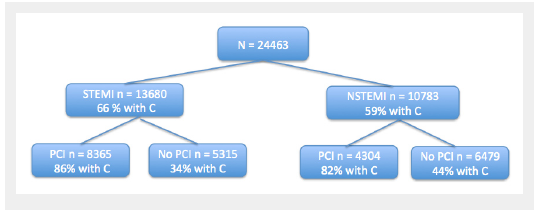
Flow chart of the patient regarding STEMI, NSTEMI and PCI or no PCI and percentage of patients treated with clopidogrel ( C ).